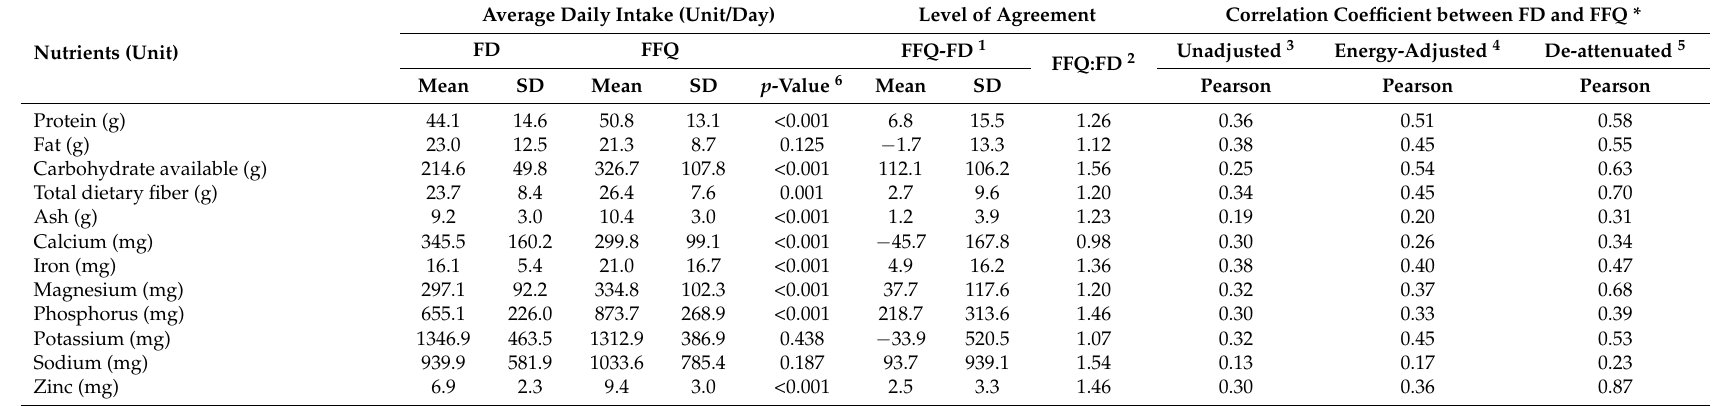
Table 4. Degree of association and level of agreement between average daily nutrient intakes by food diary (FD) and by semi-quantitative food questionnaire (FFQ). Average Daily Intake (Unit/Day) Level of Agreement Correlation Coefficient between FD and FFQ * FFQ Unadjusted 3 Energy-Adjusted 4 De-attenuated 5 Nutrients (Unit) FFQ:FD 2 Mean Mean p -Value 6 SD Pearson Pearson Pearson Protein